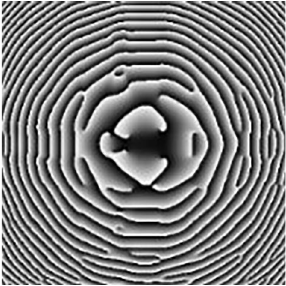
Figure 6. Phase pattern of the DOE used to correct the VCSEL beam divergence and form a cross in the far field.